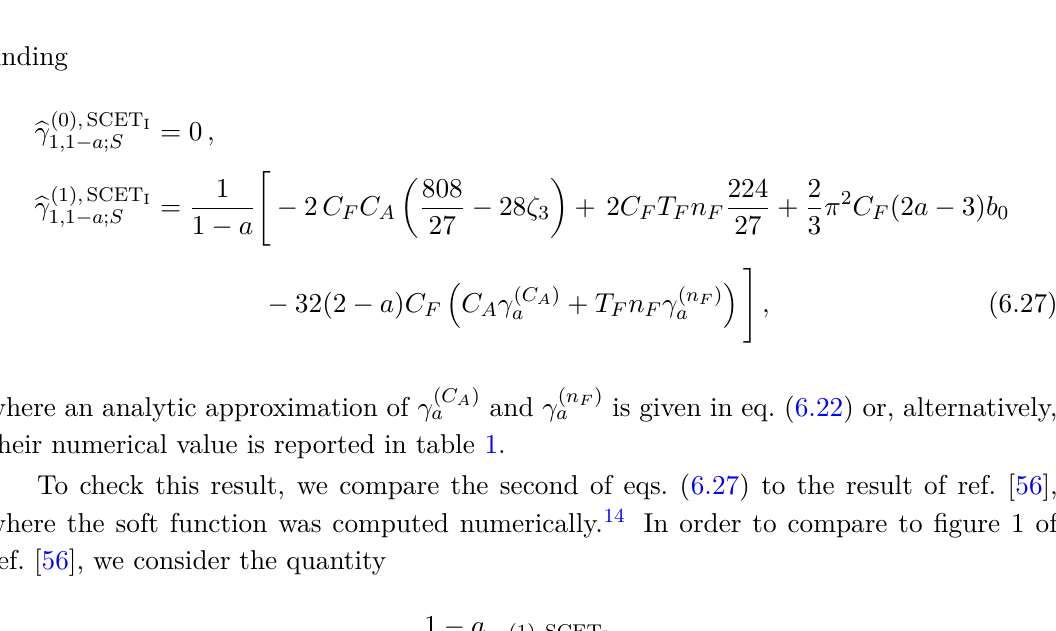
(left) and C (right) color F C F n F A C F